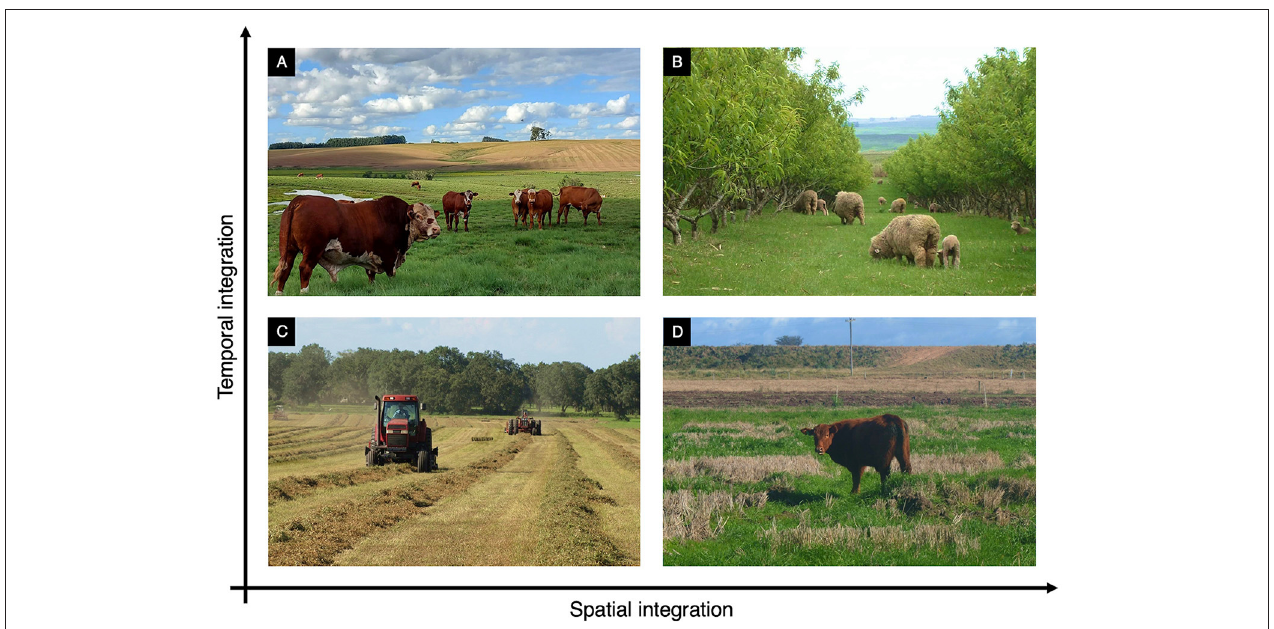
FIGURE 2 | Examples of integrated systems in multiple spatio-temporal designs. The axes denote the degree of interspersion in which crops and livestock are integrated along a spatio–temporal continuum. For a purpose of simplicity, only four discrete examples are shown, but multiple spatio-temporal designs are possible (see Bell and Moore, 2012). (A) Soybean cropping and native grasslands simultaneously occurring in neighboring fields. Pollination services for soybeans are enhanced because native grassland ecosystems provide habitat for a diversity of pollinators. Photo credit: Méia Albuquerque. (B) Sheep grazing the understory vegetation of a peach orchard. Grazing reduces the competitiveness of weed species and redistributes nutrients over the orchard. Photo credit: Thomaz Mercio. (C) Farmers harvesting hay. Integration at the landscape level involves coordinate exchanges of products or byproducts such as hay and manure between specialized crop and livestock farms. Photo credit: Marcelo Wallau. (D) Succession of crops and livestock in the same paddock, where stubble and cover crops are grazed by domestic herbivores, usually such as cattle and/or sheep. The picture shows a steer grazing in an Italian ryegrass pasture in winter following rice cultivation. Photo credit: Fernanda